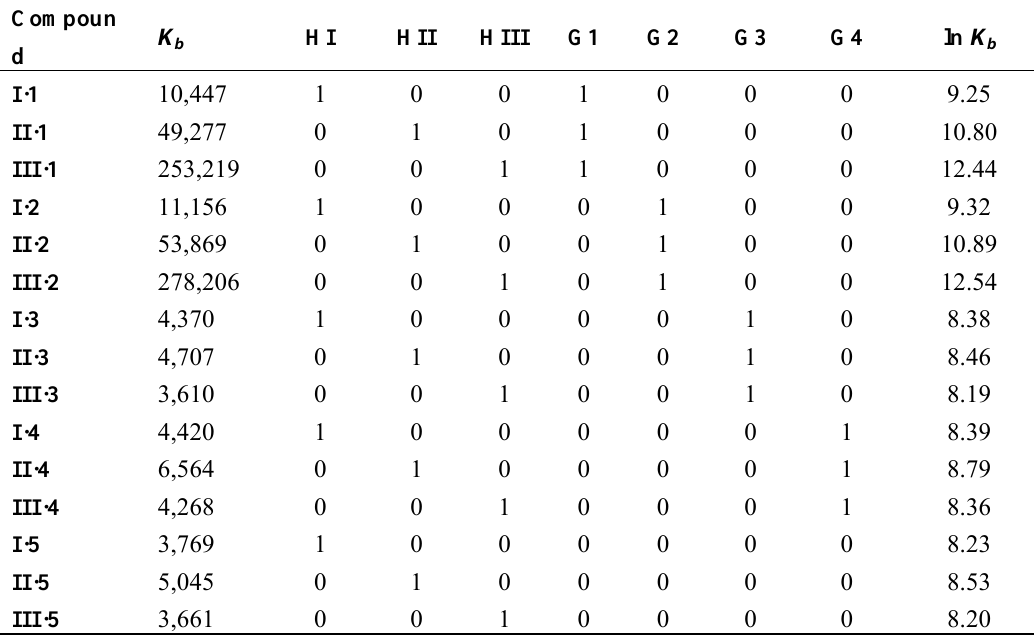
Table 2. Absence-presence